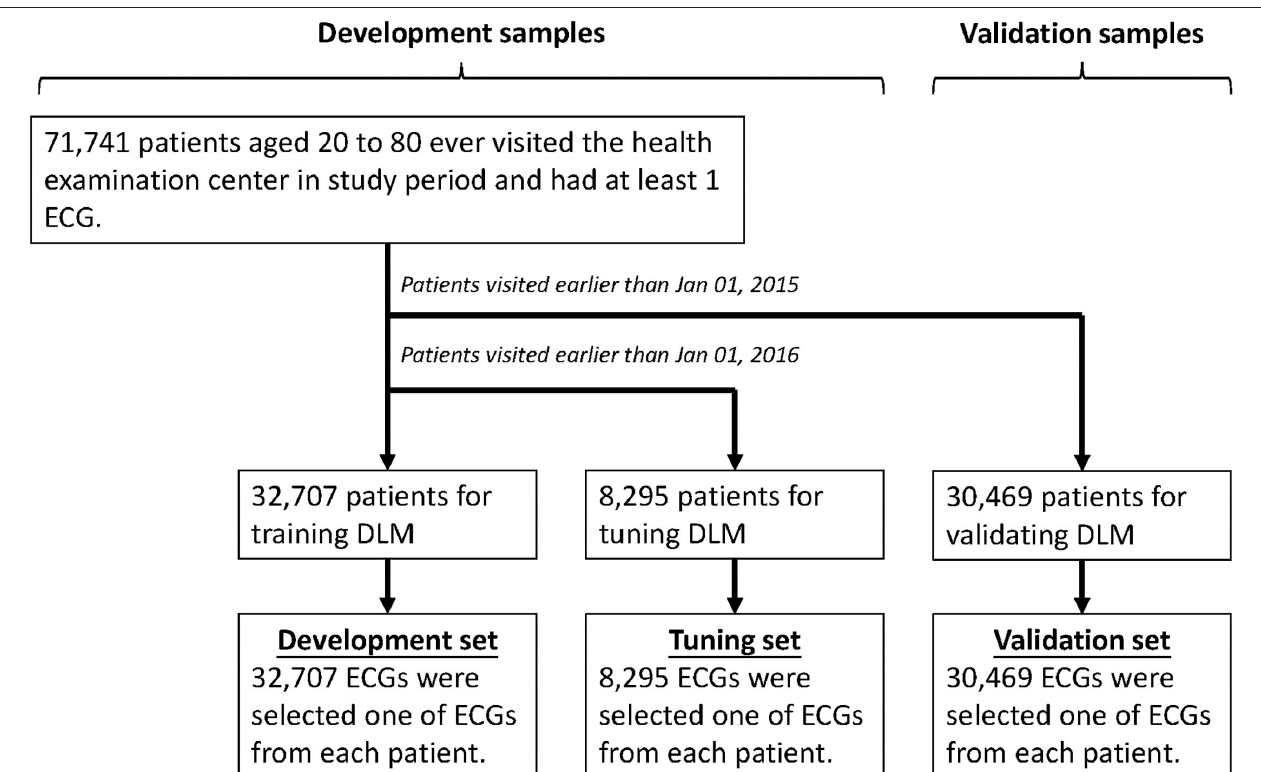
FIGURE 2 | Development, tuning, and validation sets generation. Schematic of the data set creation and analysis strategy, which was devised to assure a robust and reliable data set for training, validating, and testing of the network. Once the data of patient were placed in one of the data sets, that individual’s data were used only in that set, avoiding “cross-contamination” among the development, tuning, and validation sets. The details of the flowchart and how each of the data sets was used are described in the